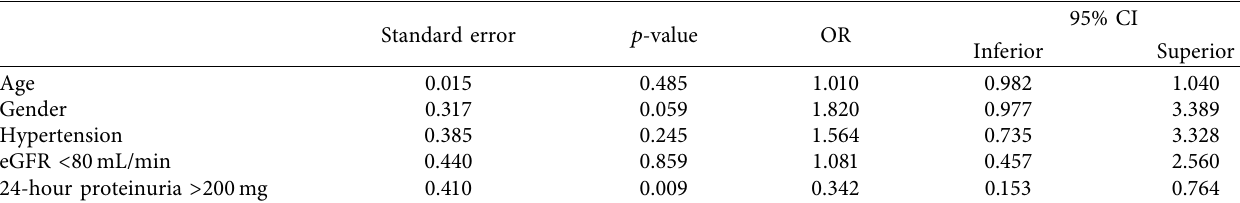
Table 2: JCV viruria-LKD candidates relationships (logistic regression).